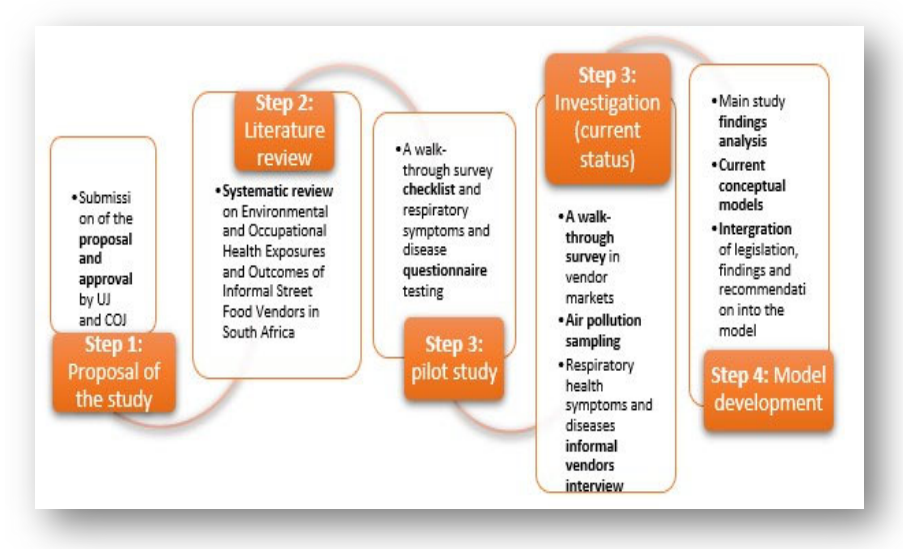
Figure 1. The process followed in developing the informal vendors’ integrated healthy workplace management model.